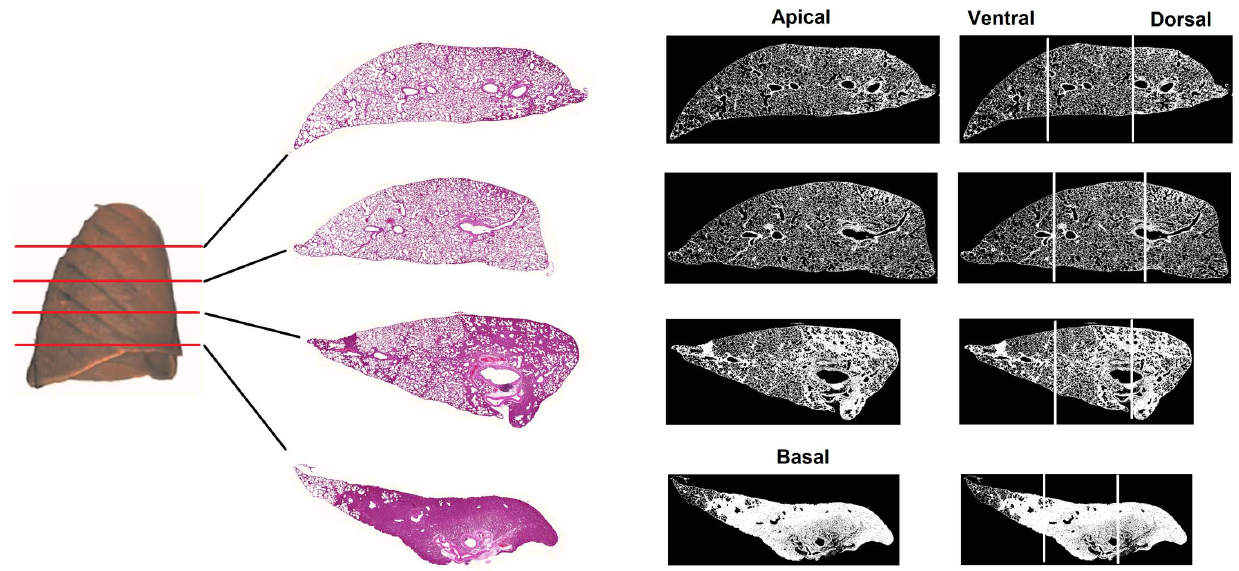
Figure 2. Air fraction obtained by histology images. Air fraction analysis of apex and base (A) and ventral and dorsal lung areas (B) in the groups: VCV_E (volume-controlled mode and PEEP minErs ; n=6), VCV_E + 2 (volume-controlled mode and PEEP minErs plus 2 cmH 2 O; n=6), VCV_E-2 (volume-controlled mode and PEEP minErs minus 2 cmH 2 O; n=6), VV_E (variable ventilation and PEEP minErs ; n=6), VV_E + 2 (variable ventilation and PEEP minErs plus 2 cmH 2 O; n=5), VV_E-2 (variable ventilation and PEEP minErs minus 2 cmH 2 O; n=6). Ventilatory mode and PEEP effects were tested with two-way ANOVA followed by Tukey post hoc. t test was used to detect differences between ventilated and non-ventilated groups and then correction by comparisons ensued. Statistical significance was accepted at p , 0.05. *p , 0.05.